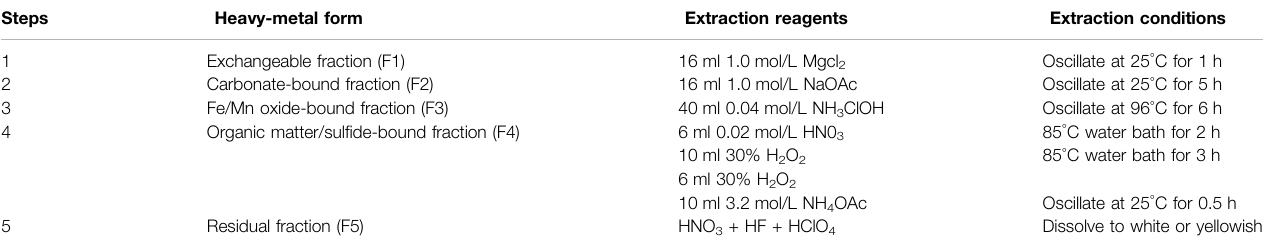
TABLE 3 | Tessier extraction method operation steps.